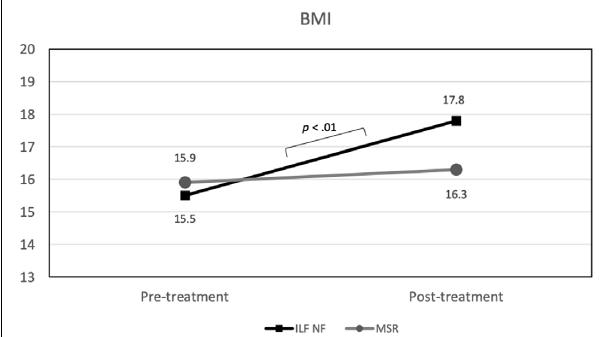
FIGURE 5 | Group × Time interaction effect on BMI (significant mean differences are